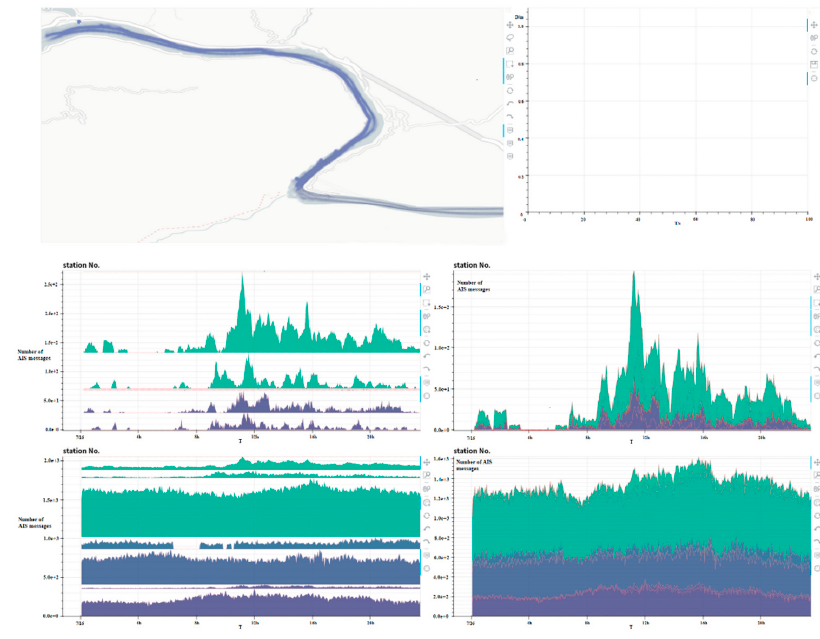
Figure 18. Stack graph of a base station in the river branch.